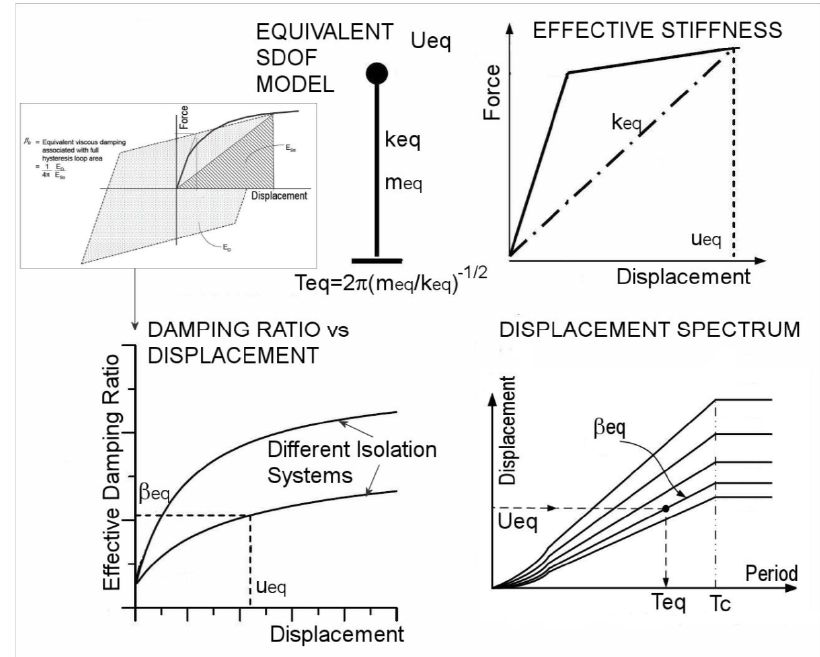
Figure 20. Design steps of DDBD for SI structures [74] .